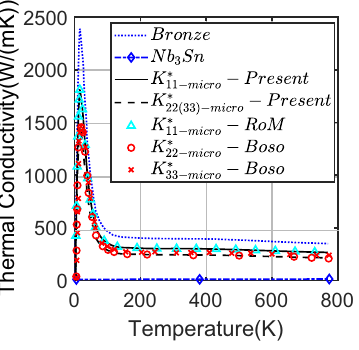
Figure 7: Comparison of homogenized thermal conductivity gene - rated by LEHT and Boso et al. [ 13 ] with v 0.72 f = for multiple fi lament groups at